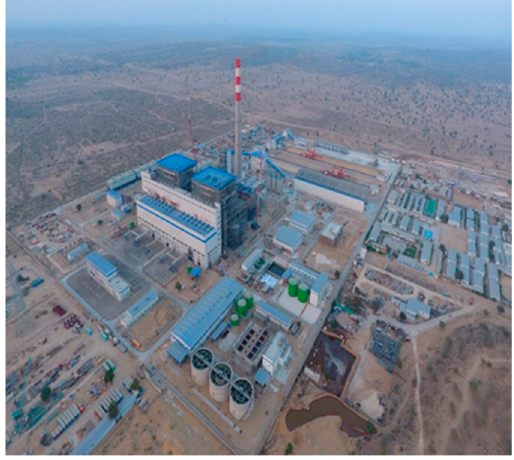
Figure 2. An ariel view of EPTL power plant in Thar.